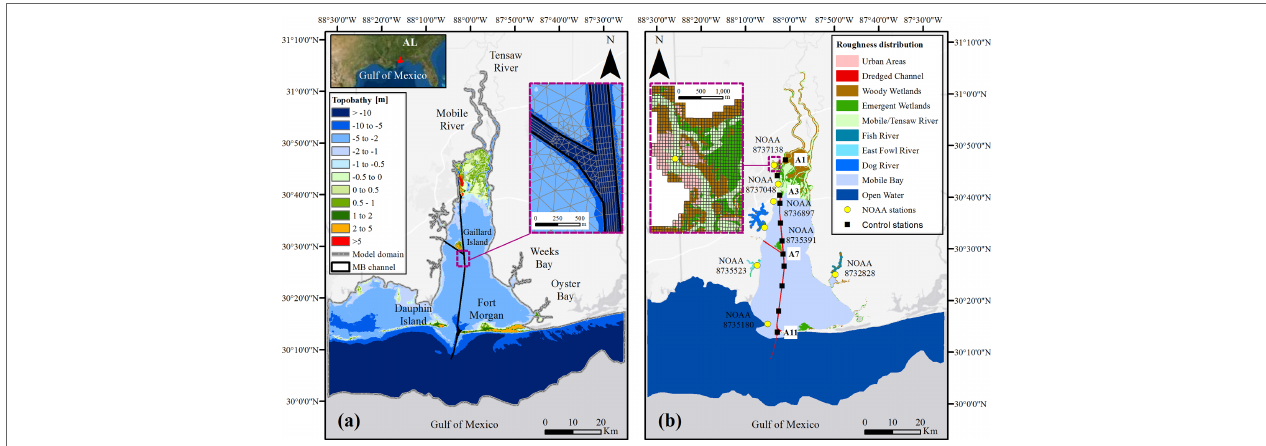
FIGURE 1 | Map of Mobile Bay (MB), AL in the Gulf of Mexico. (A) Topography and bathymetry (topobathy) of MB referenced with respect to the North American Vertical Datum 1988 (NAVD88). Right box shows a detailed view of the unstructured mesh generated to accurately represent the MB channel. (B) Land cover classes and associated roughness distribution used for model calibration at NOAA stations (yellow circles). Left box shows a fine mesh resolution used to simulate wetland inundation around the navigational channel. Control stations (black squares) are used to compute water level